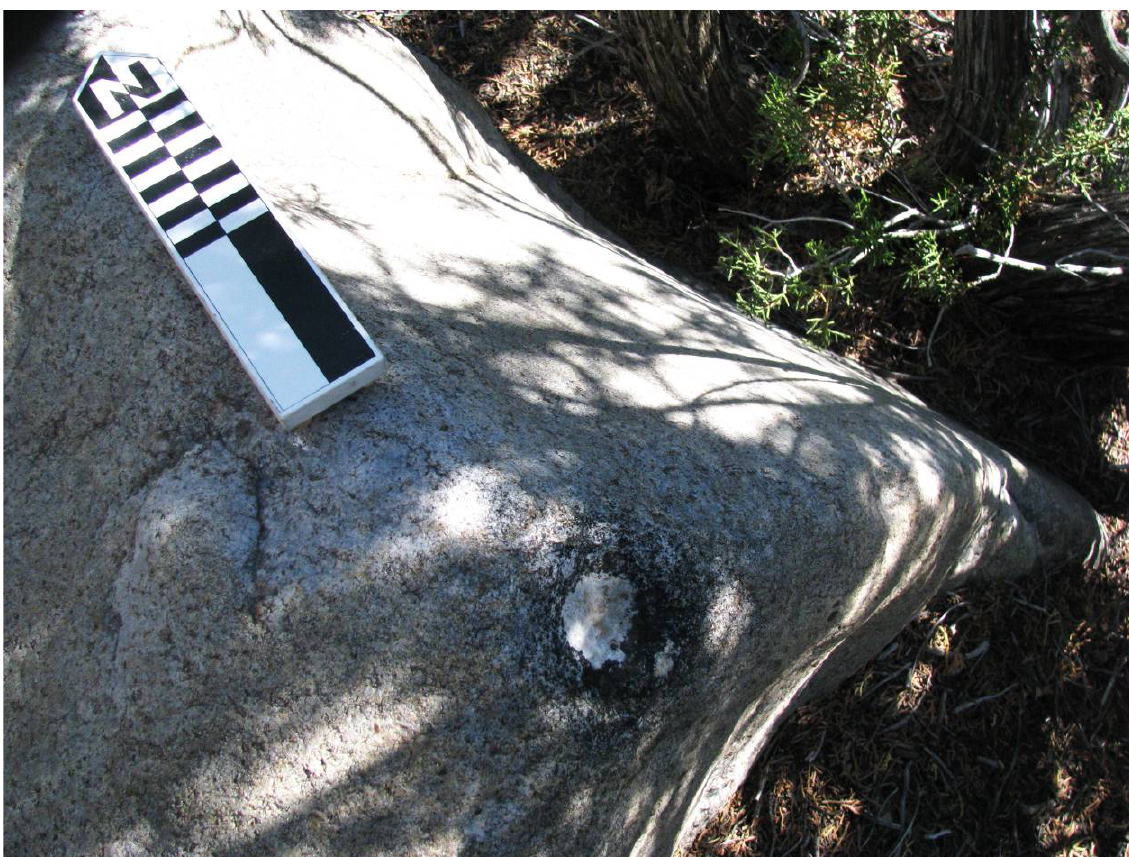
Figure 4. A cupule with pounded marks at